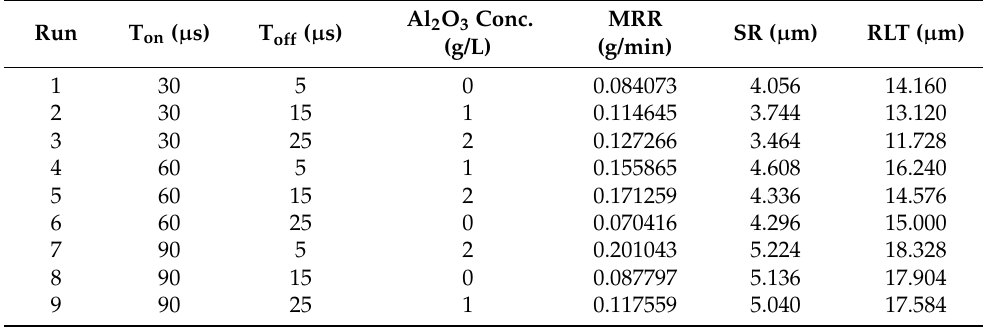
Table 2. Taguchi’s L 9 OA and the measured values of MRR, SR, and RLT.